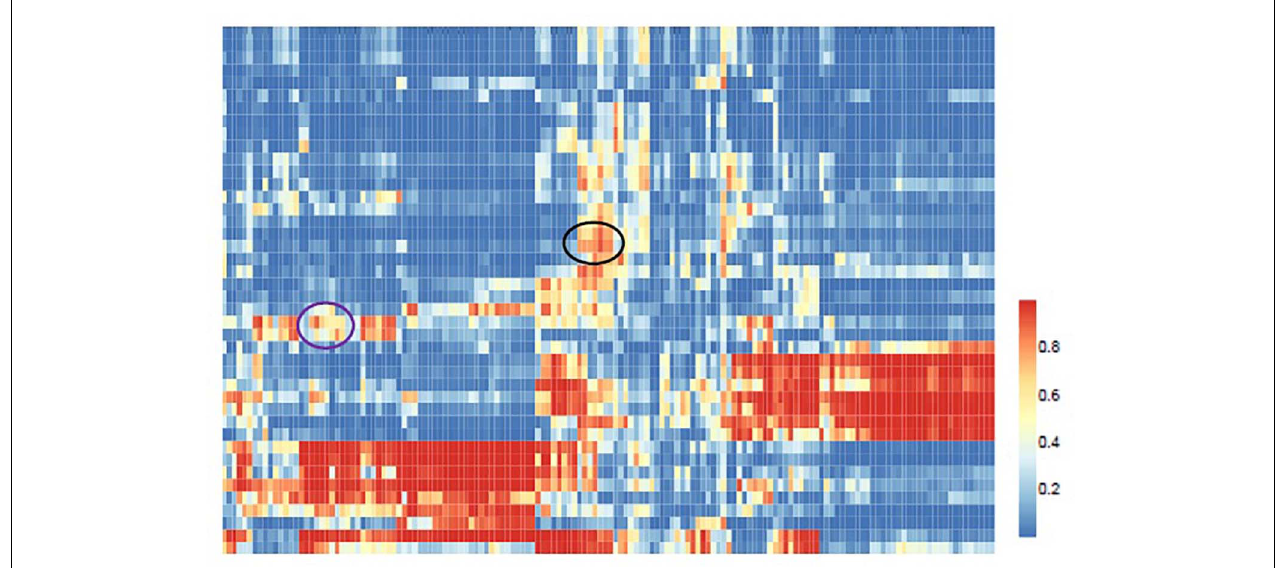
FIGURE 4 | Global view of the predicted drug-metabolite associations. Hierarchical clustering of the ILMF scores between 42 drugs and 150 metabolites. The color of each cell represents the ILMF score of a drug (row) and a metabolite (column), where red/blue indicates high/low ILMF scores.